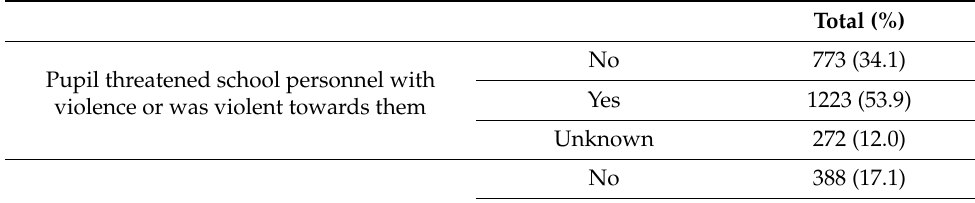
Table 2. School violence in comprehensive in schools ( n =